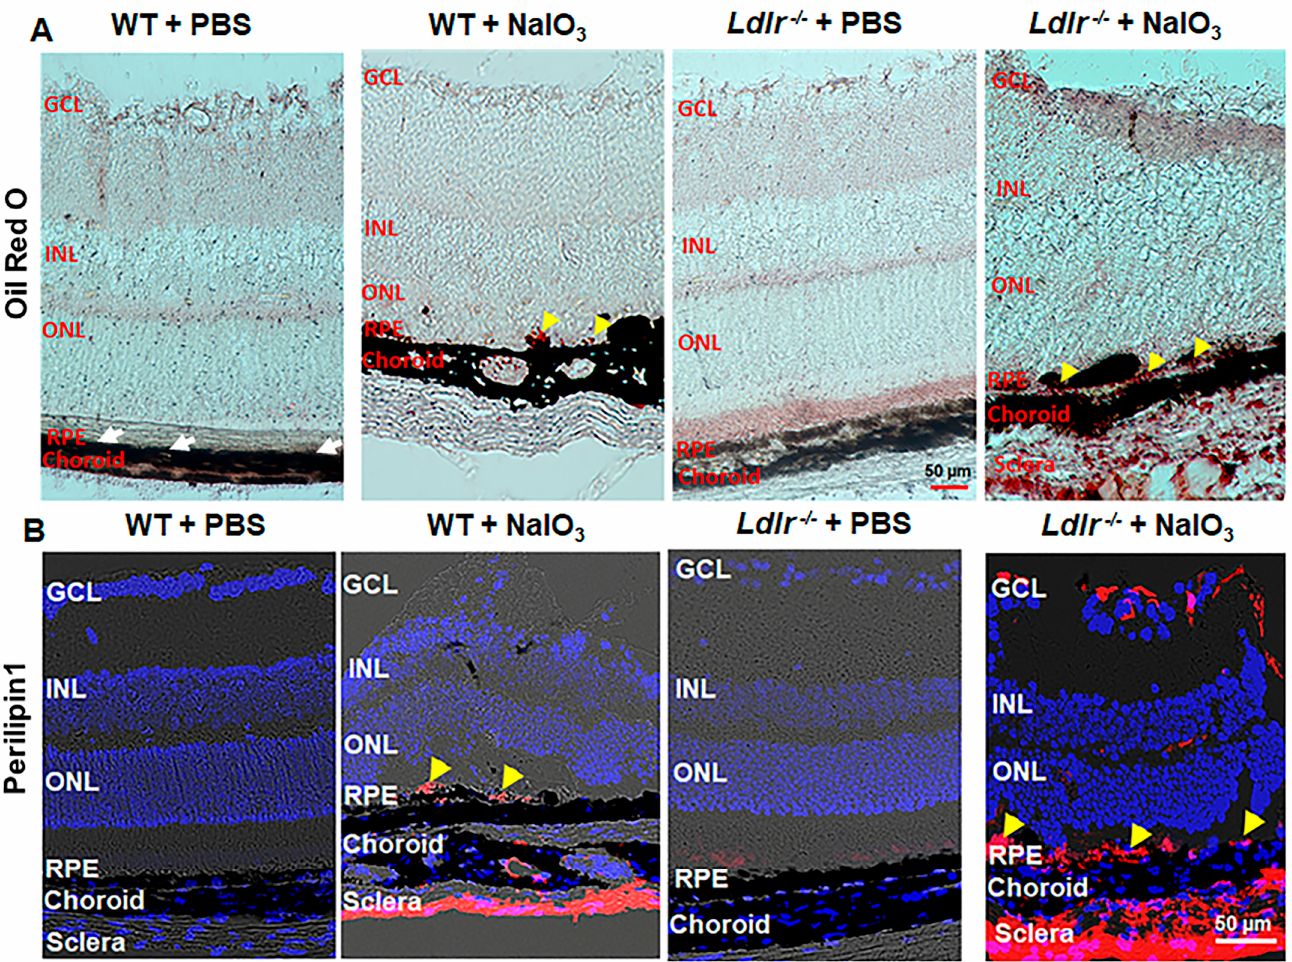
Figure 7. Deficiency of LDLR leads to lipid deposition in the mouse outer retina. Representative images of lipid deposits revealed by neutral lipid staining with Oil Red O ( A ) show more deposits in the Ldlr -/- retina compared to WT challenged with NaIO 3 . Lipid deposits can be seen marked by arrowheads in the RPE. In the WT + PBS, RPE layer is indicated with white arrows. ( B ) Perilipin 1, a protein associated with lipid droplets, was clearly upregulated after being treated with NaIO 3 . The staining was very intense and widely distributed in the Ldlr -/- mice upon NaIO 3 administration. The yellow arrowheads show perilipin1 expression in the RPE layer. GCL: ganglion cell layer; INL: inner nuclear layer; ONL: outer nuclear layer; RPE: retinal pigment epithelium. Scale bar: 50 µm.